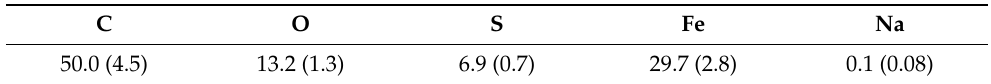
Figure 6. SEM images of separate PAH/PSS/PAH/MNP/PSS/PAH/PSS microcapsules ( a ) and of a magnified microcapsule shell with detectable MNPs ( b ).